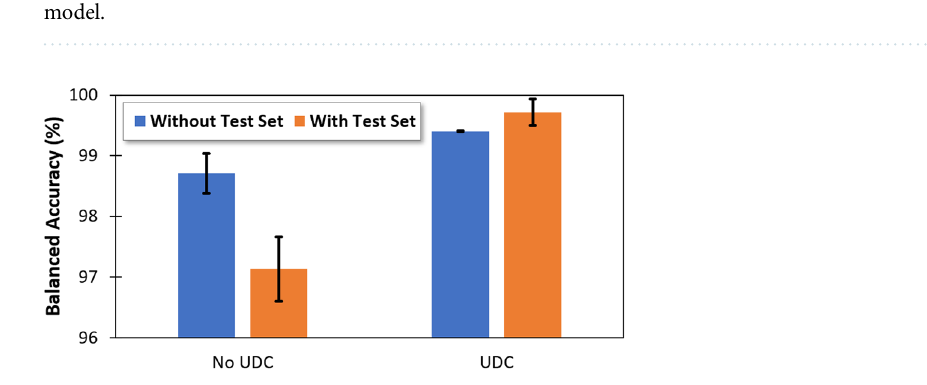
Figure 3. The colors of the bars represent the performance of the model on the validation set, with (orange) and without (blue) the test set included in the training set. AI performance drops when the uncleansed blind test set is included in the training set, indicating a considerable level of poor-quality data in the test